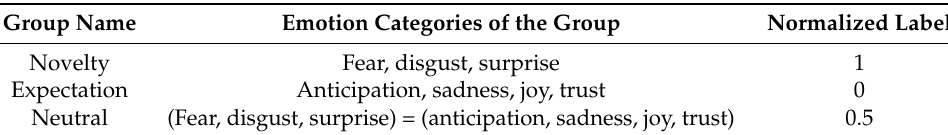
Table 3. The emotion groups are divided based on analysis of crowd comments’ emotions and their association with fake and real news.